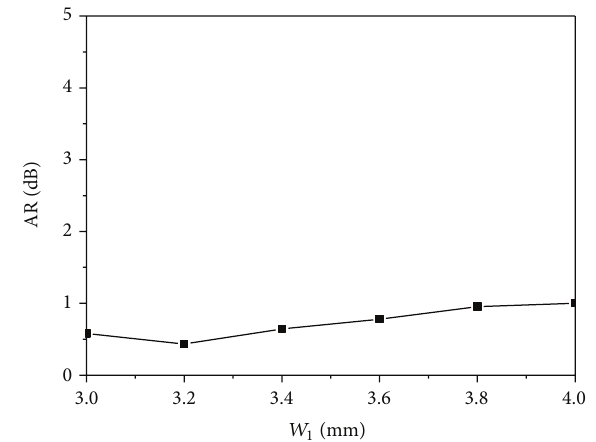
Figure 7: Axial ratio of the SIW leaky-wave antenna as function of width 𝑊 of the N-shaped slot for 𝑓 = 8 GHz, 𝐿 1 = 4 mm, 𝐿 = 5 mm, and 𝑊 = 4.2 mm.